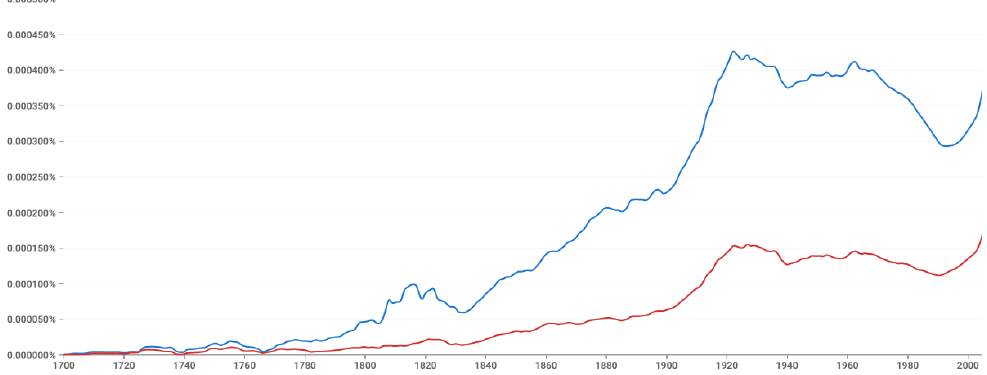
Figure 5. Frequency of _VERB_ nada más que, overall (blue), and negated